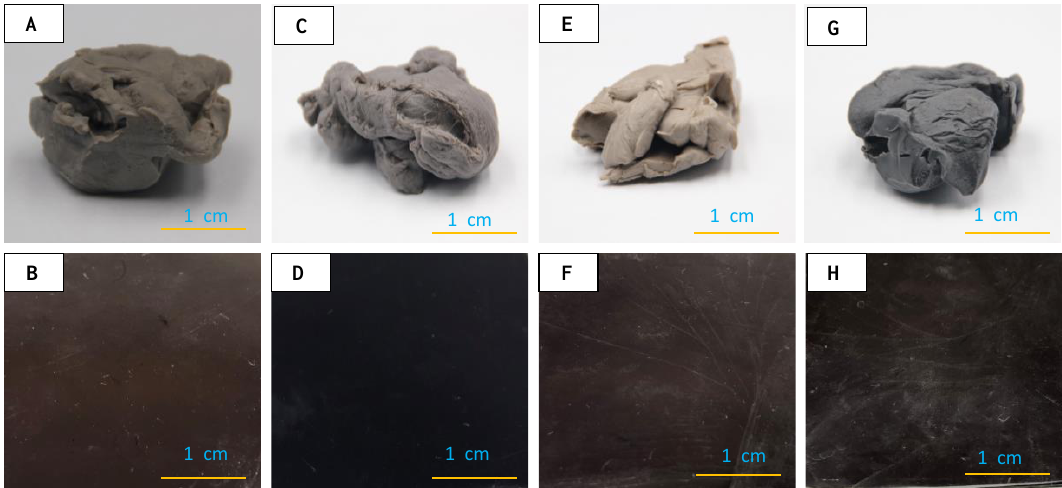
Figure 3. Photographs of one-year-stored compounds ( A , C , E and G ) and vulcanizates ( B , D , F and H ) comprising Si69 ( A , B , E and F ) or Si69 / [EMIM]OAc ( C , D , G and H ) at ϕ = 0.04 ( A – D ) and ϕ = 0.177 ( E – H ). Color di ff erences are observed for the compounds and vulcanizates and the marks on the surface of the vulcanizates are generated after separation of the mold for the compression molding.